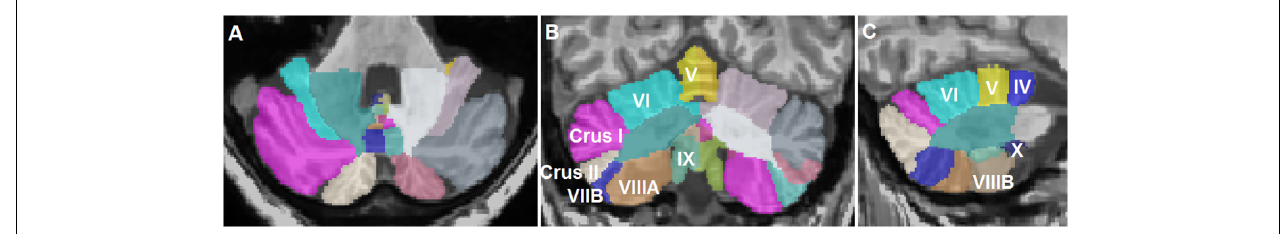
FIGURE 1 | Representative segmentation of a T1-weighted magnetic resonance imaging scan of a patient with essential tremor using the CEREbellum Segmentation pipeline (Romero et al., 2017). (A) Axial, (B) coronal, and (C) sagittal representations of the segmented lobules.